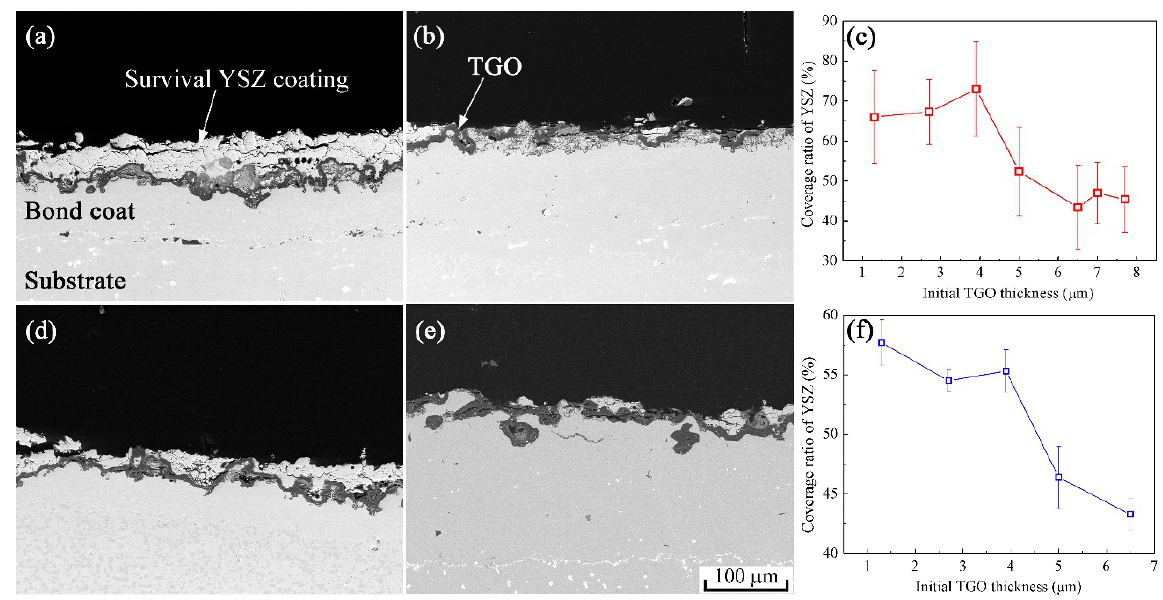
Fig. 41 Cross-sectional microstructures of APS TBCs with different initial α -Al 2 O 3 -based TGO thicknesses after failure: (a) 1.3 μ m and (b) 6.5 μ m TGO under burner cycling, (d) 1.3 μ m and (e) 6.5 μ m TGO under furnace cycling, and (c, f) coverage ratios of the YSZ coating on the fracture surface.